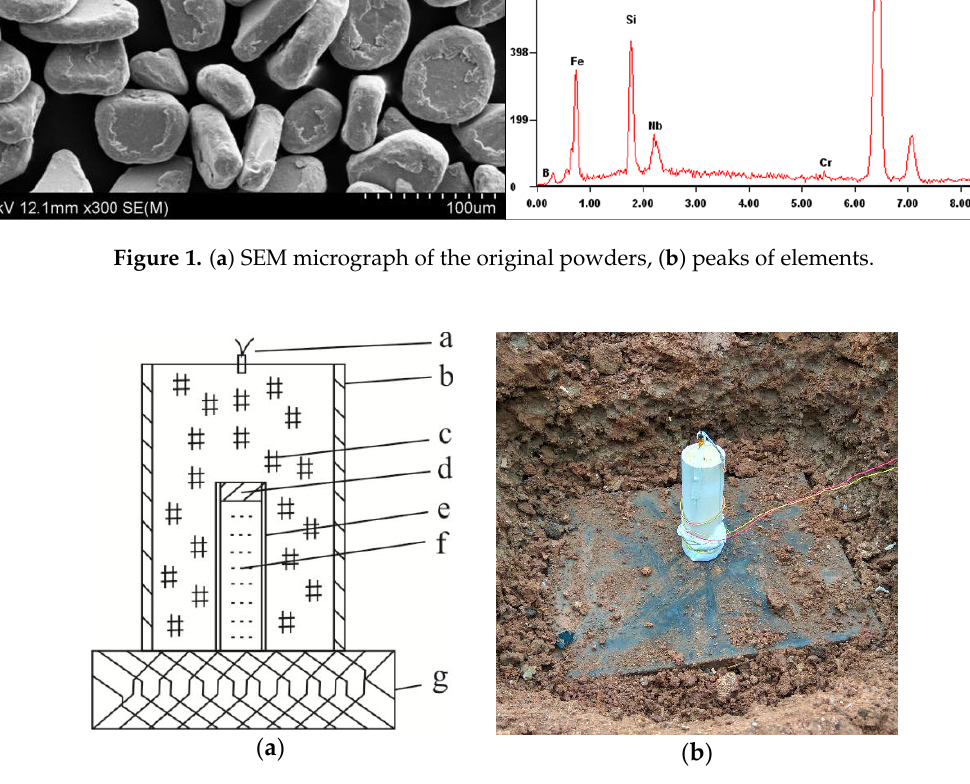
Figure 2. Schematic view ( a ) and actual diagram ( b ) of explosive consolidation device: a—detonator, b—the outer cylinder, c—emulsion explosives, d—the upper plug, e—copper tube, f—Fe-based amorphous powders, g—baseplate.